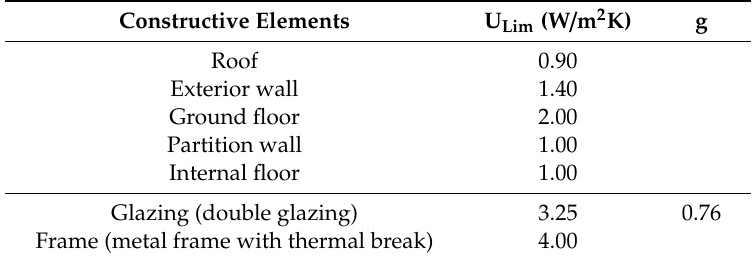
Table 1. Design data of the building envelope of Case 1979. The limit values of the overall heat transfer coe ffi cient of the building envelopes for both normative requirements.